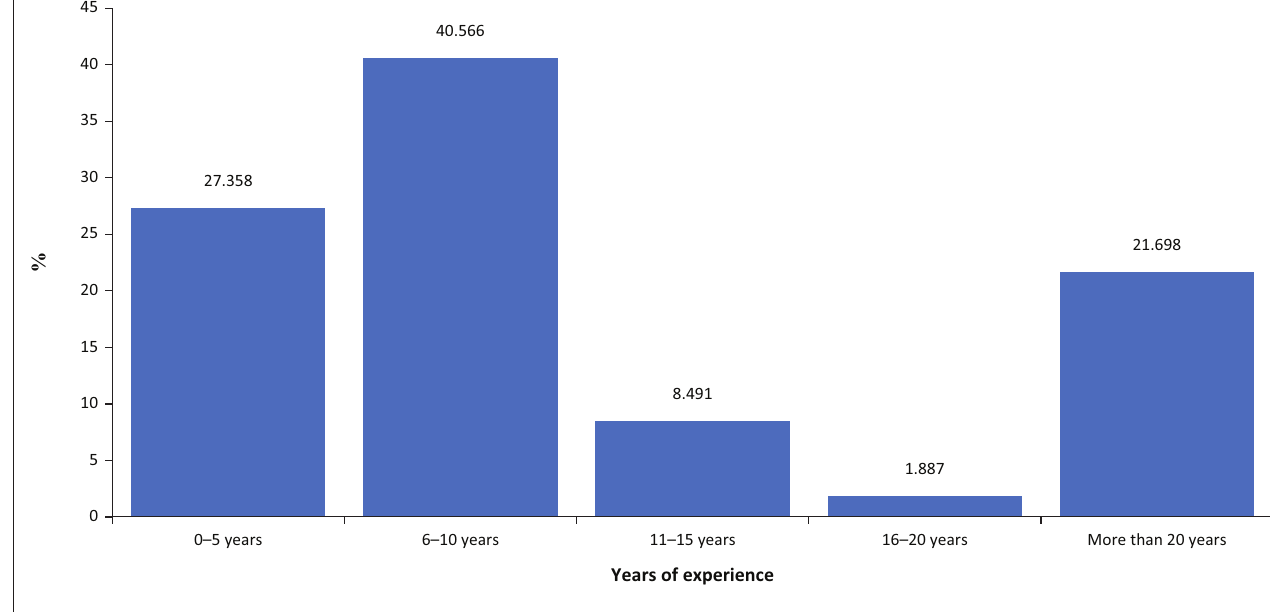
FIGURE 3: Distribution of years of experience at African power generation and distribution company Customer Service Centre